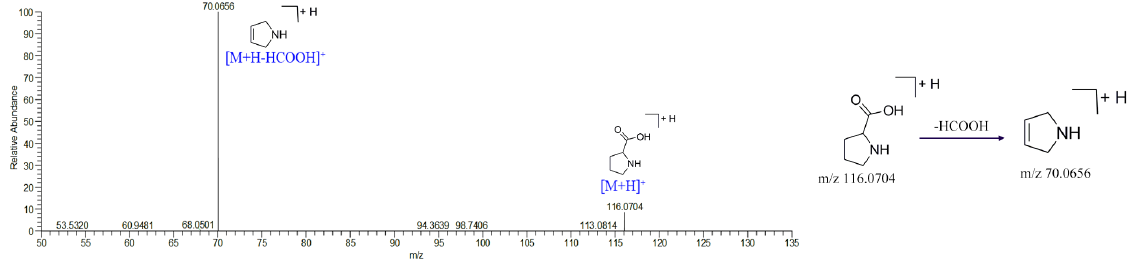
Figure 5. Characteristic of MS/MS spectra and possible fragmentation pathways of proline.